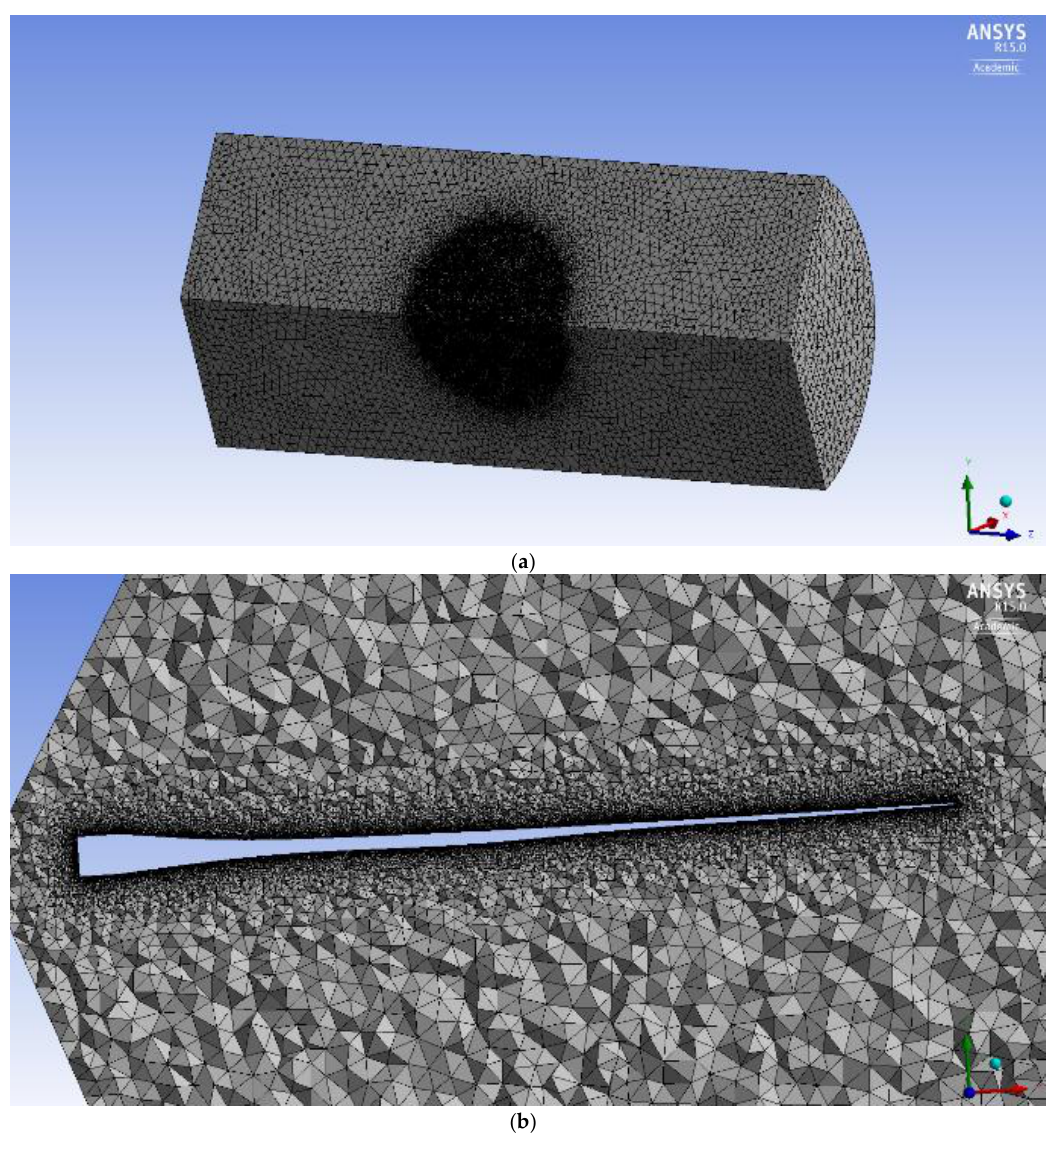
Figure 7. Tetrahedral meshing results in the absence of bumps. ( a ) Meshes in the whole domain ( b ) Meshes around the blade.